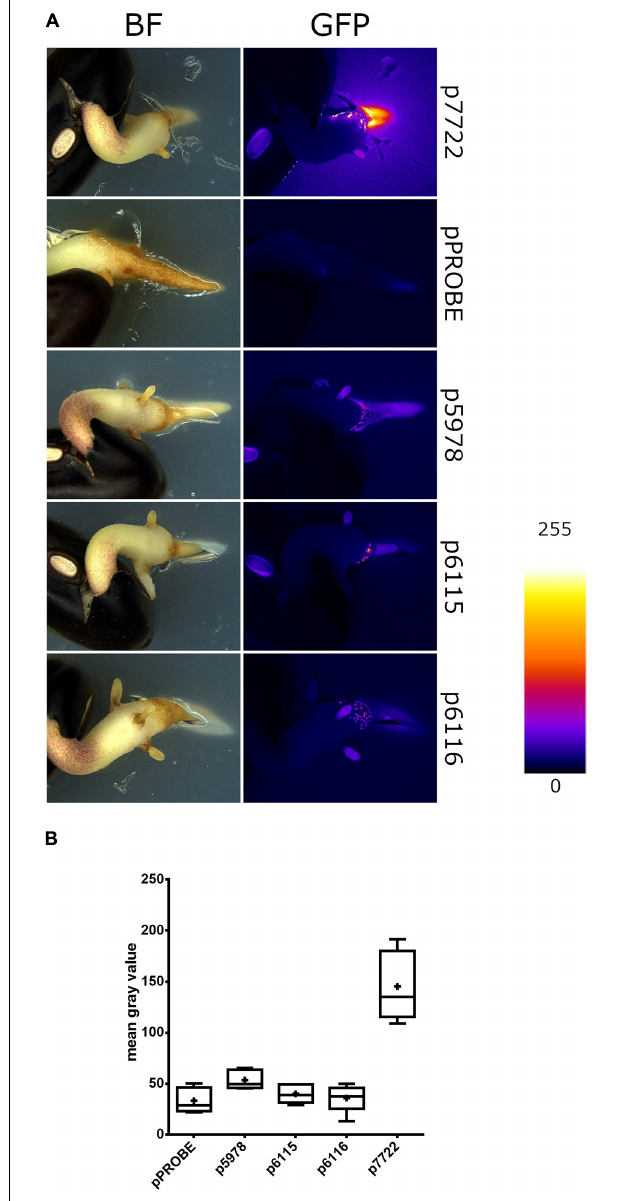
FIGURE 4 | The gfp expression of T6SS-b (p5978) and T6SS-3 (p6115 and p6116) clusters on bean roots. (A) Representative stereomicrographs. The empty pPROBE vector samples only display plant autofluorescence. All samples were imaged in the same conditions. Fire LUT indicates fluorescent signal intensity. (B) Semiquantitative analysis of GFP expression near P. vulgaris root tips. Plus signs indicate the arithmetic mean, whiskers minimum to maximum values and black dots outliers according to Tukey’s test. Significant differences between samples were analyzed in a